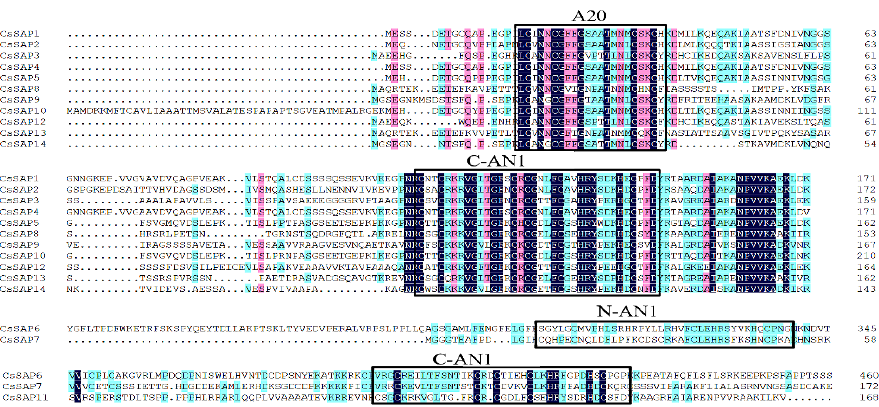
Figure 1. Multiple alignments of the A20/AN1 domain in tea plant CsSAPs. The conserved domains are shown in boxes, identical amino acids are shown with a dark blue background (similarity: dark blue = 100%; pink > 75%; cyan > 50%). Table 1. Properties of CsSAPs identified from tea plant genome.